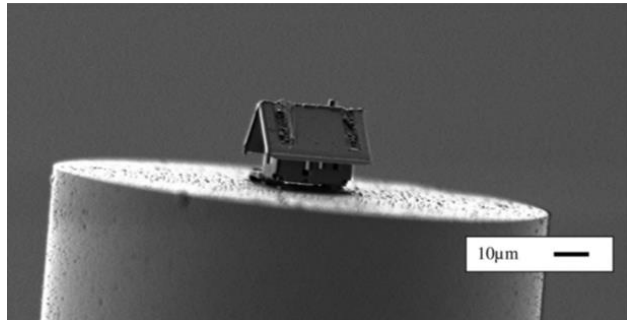
Figure 4. Microhouse assembled with origami and welded on top of the facet of an optical fiber. Reprinted with permission from [35]. Copyright 2019, American Vacuum Society.